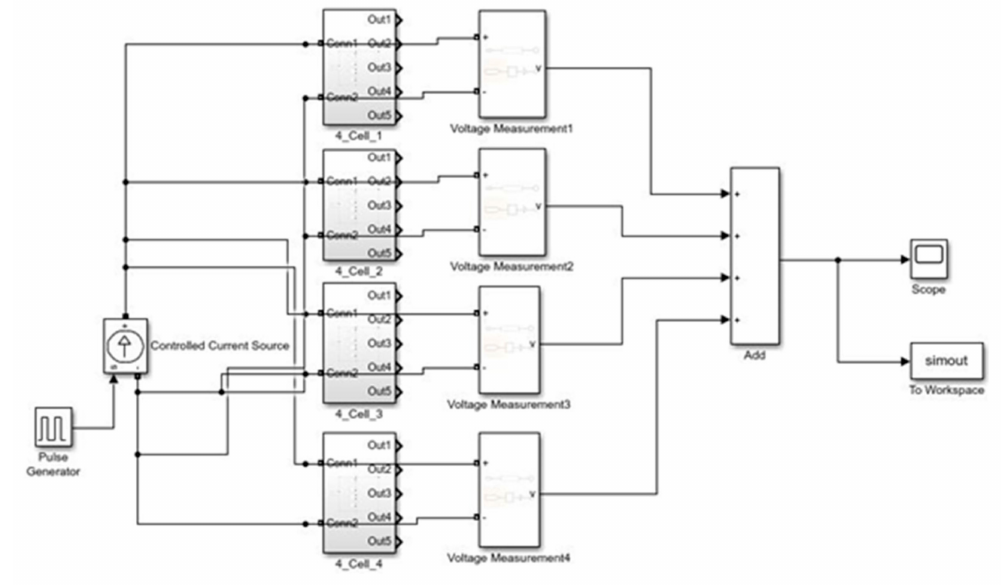
Figure 12. Simulink model of an 80 Ah SLI-type battery pack.